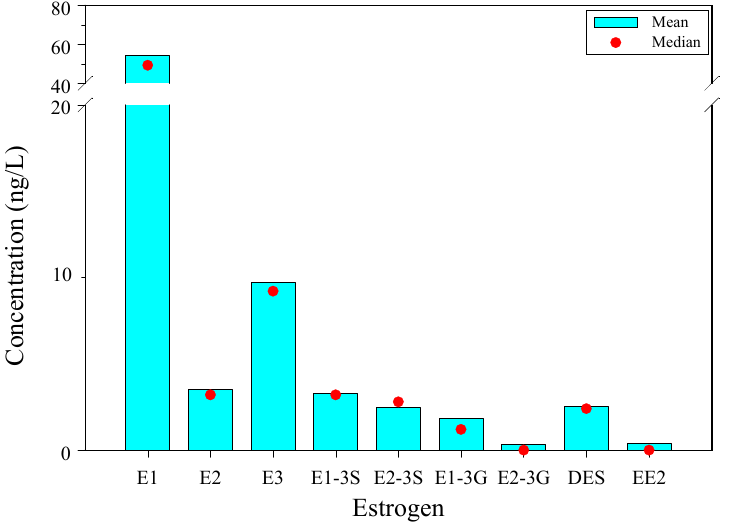
Figure 2. Estrogen mean concentration and median values.